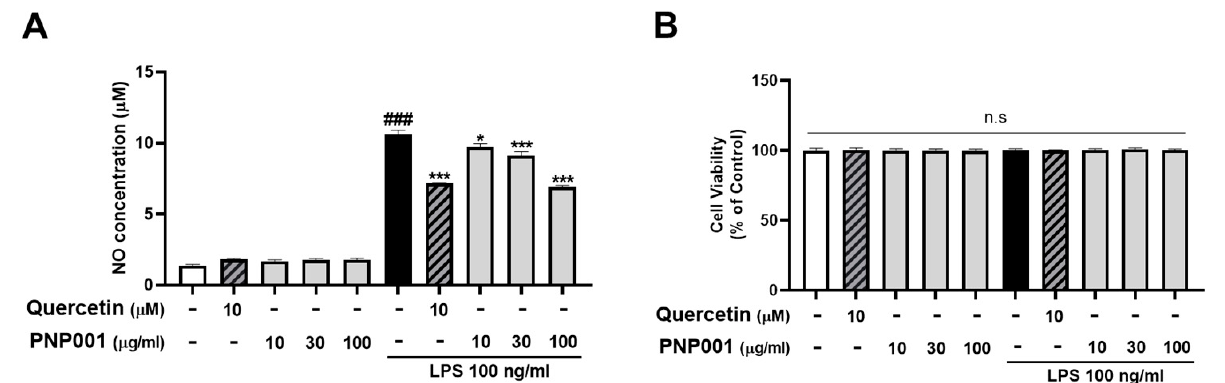
Figure 1. Effects of PNP001 on nitric oxide (NO) production and cell viability in BV2 microglial cells. The cells were treated with PNP001 (10, 30, or 100 µ g/mL) 1 h before lipopolysaccharides (LPS; 100 ng/mL) stimulation for the last 23 h. NO concentration in the supernatant of the cells was measured using the Griess reagent ( A ). Cell viability was assessed using (4,5-dimethylthiazol-2-yl)-2,5-diphenyltetrazolium bromide (MTT) assay ( B ). Values are the mean ± standard error of the mean (S.E.M). Data were analyzed by one-way analysis of variance (ANOVA), followed by Dunnett’s post hoc test. ### p < 0.001 compared to the control group; * p < 0.05 and *** p < 0.001 compared to the LPS-only-treated group; n.s, not significant.